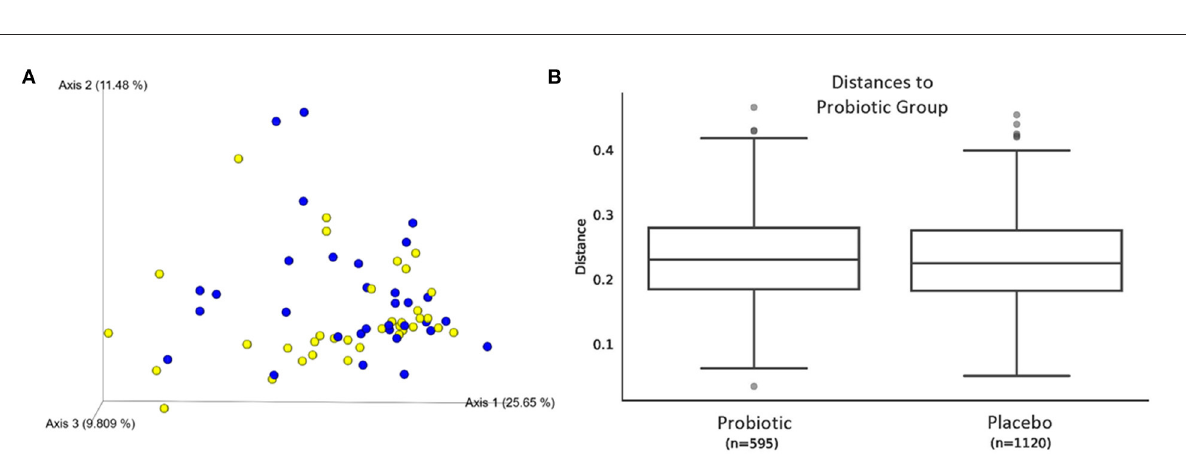
FIGURE4 Beta diversity of microbiota from 67 kittens receiving probiotic or placebo. (A) Weighted UniFrac principal coordinates analysis plot showing similar phylogenic diversity of microbial communities from feces of kittens receiving the probiotic (blue circles) or placebo (yellow circles). Axis 1, 25.65%; Axis 2, 11.48%; Axis 3, 9.809%. (B) Weighted Unifrac distances between microbial communities shown in (A) . PERMANOVA q =